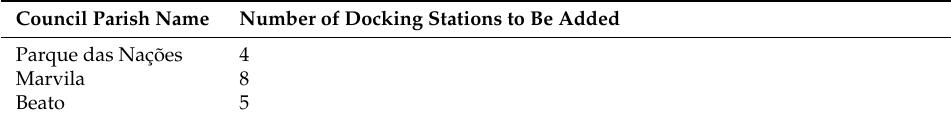
Table 3. Number of docking stations suggested to be added for each of the council parishes under